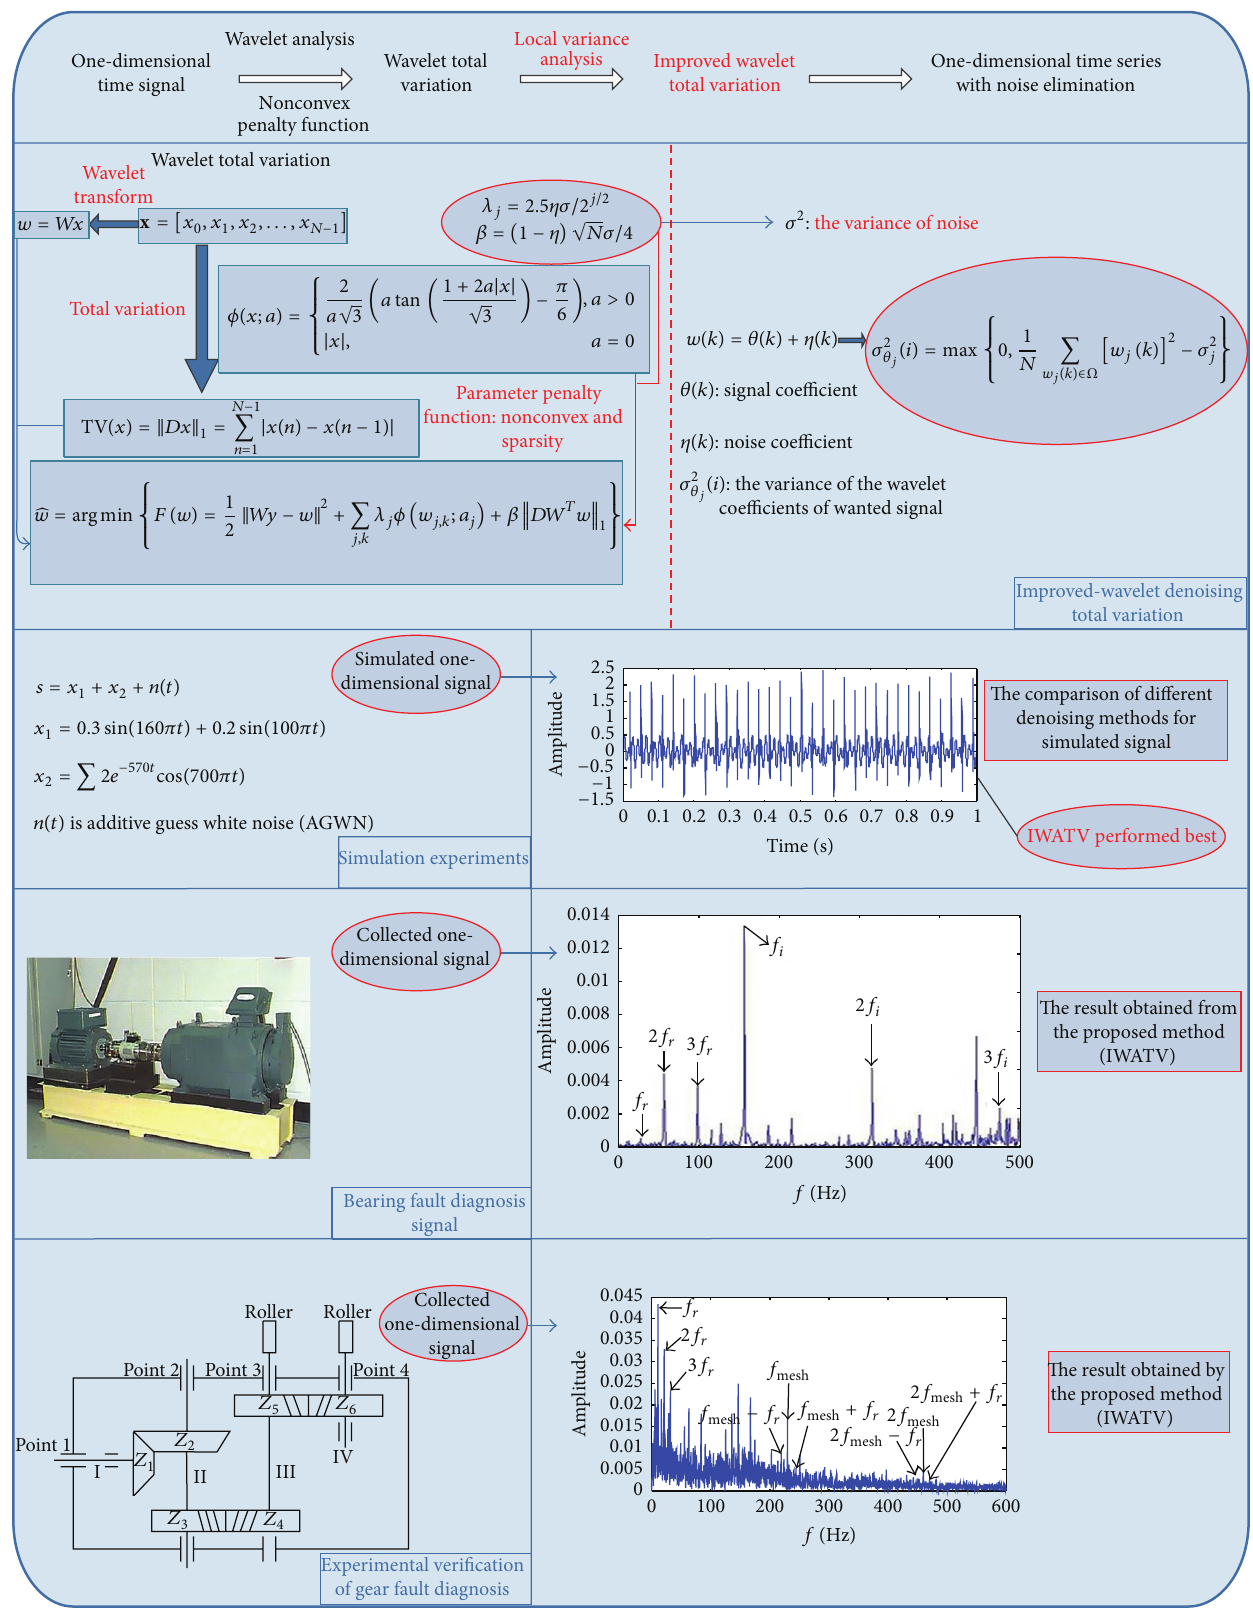
Figure 1: The fault feature extraction